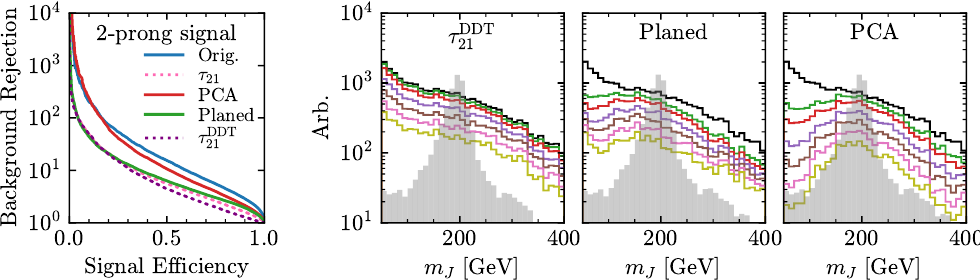
Figure 5: The left panel shows the ROC curves for the data augmented neural net- work methods of PCA and planing as well as the single variable DDT. The network trained on PCA-rescaled data is the best classifier, followed by the network trained on planed data. Both MV decorrelation techniques result in better classification than the single variable τ DDT based classification. The right panels show the background 21 only distributions for successively tighter thresholds for the DDT, Planed, and PCA classifiers: signal efficiency of 1.0 (black), 0.95 (green), 0.9 (red), 0.8 (purple), 0.7 (brown), 0.6 (pink) and 0.5 (yellow). For context, the 2-pronged signal distribution is shown as grey filled-in region. All three methods reduce the background sculpting when compared to their Fig. 4 counterparts. A full side-by-side comparison for 2, 3, and 4 prong signals is shown in App.